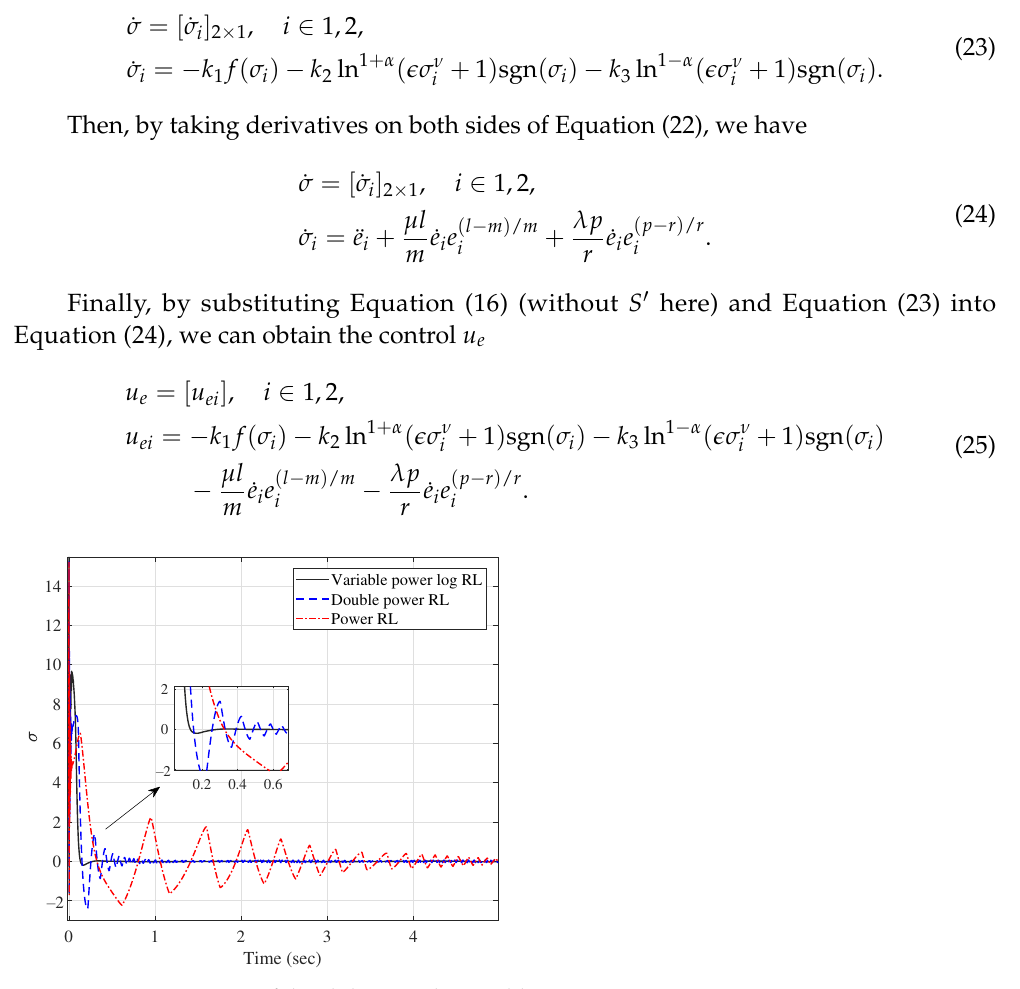
Figure 5. Time response of the sliding mode